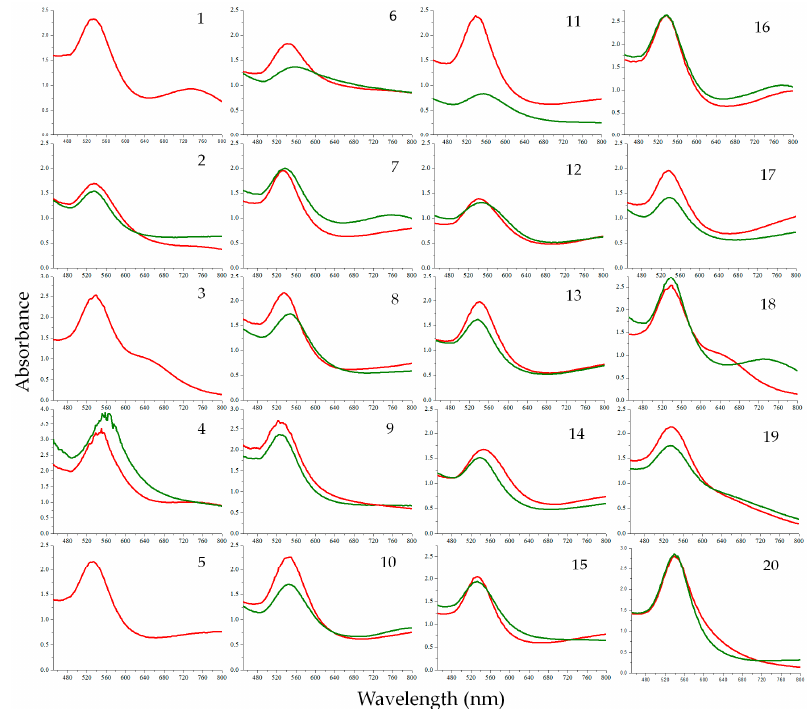
Figure 1. Comparison of the Ultraviolet-Visible Spectroscopy (UV-Vis) spectra for the AuNPs produced at 25 °C ( green line graph ) and at 70 °C ( red line graph ). The numbers on the spectra correspond to the numbers given to each plant in Table 1. Camellia sinensis (black tea) (18), Camellia sinensis (green tea) (19) and Epigallocatechin gallate (EGCG) (20) represent positive controls.